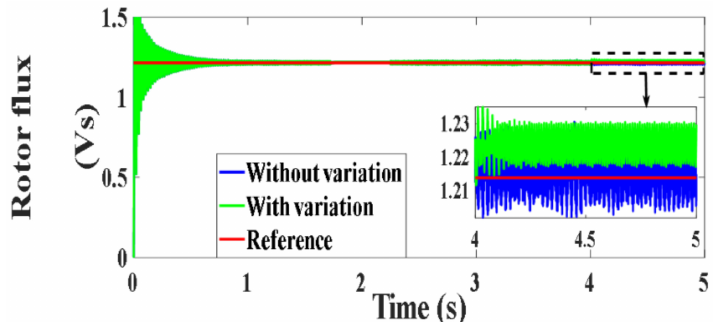
Figure 154. Rotor flux under PVC (Vs).